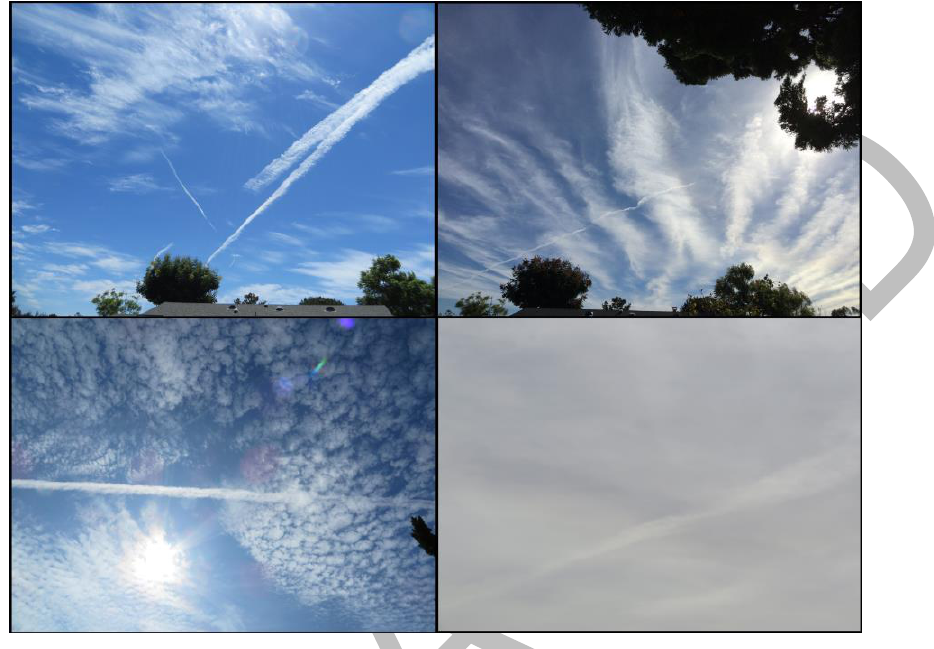
Figure 1. Composite of four images of the blue sky over San Diego taken on cloudless days showing various instances of the on-going daily tanker-jet spraying of ultrafine-particulates into the troposphere. Upper Left: Spraying just started. Note that one tanker-jet turned off the spray in mid-flight. The “clouds” are dispersed particulates; Lower Right: Overcast “clouds” produced by intense tanker-jet emplacement of